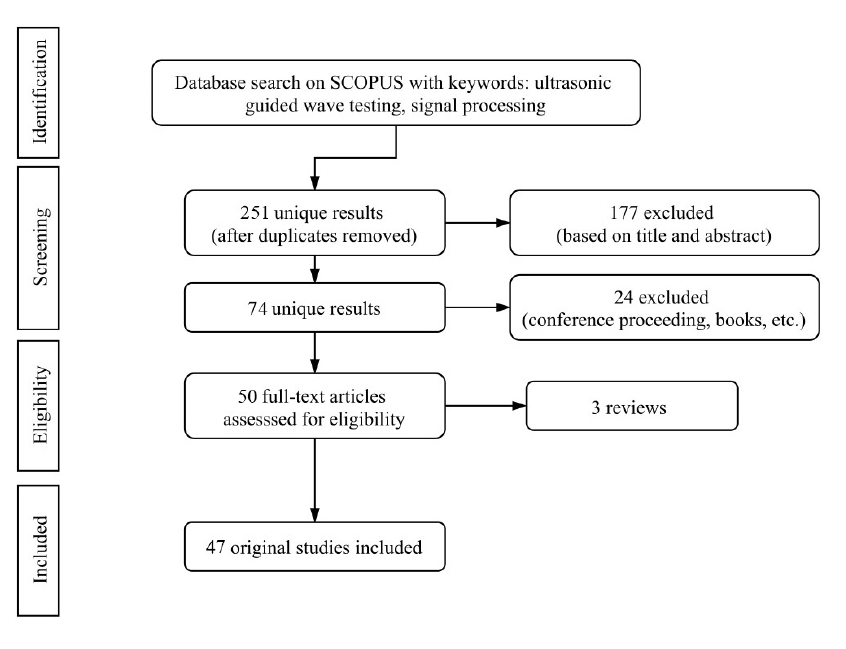
Figure 3. PRISMA study flow diagram of the performed systematic literature